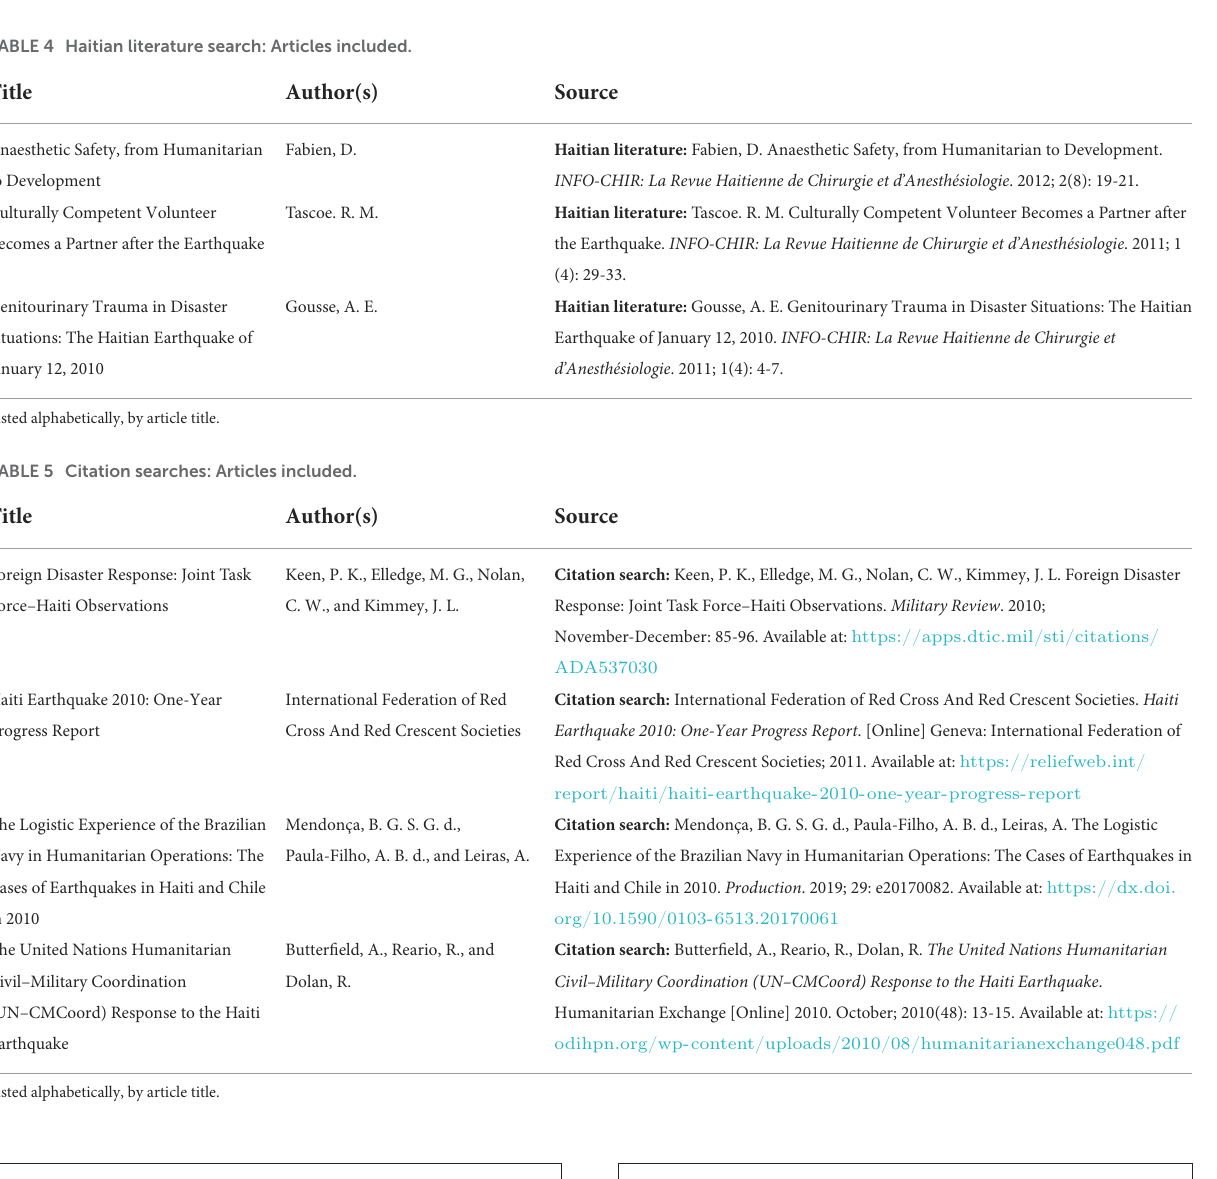
TABLE 4 Haitian literature search: Articles included.